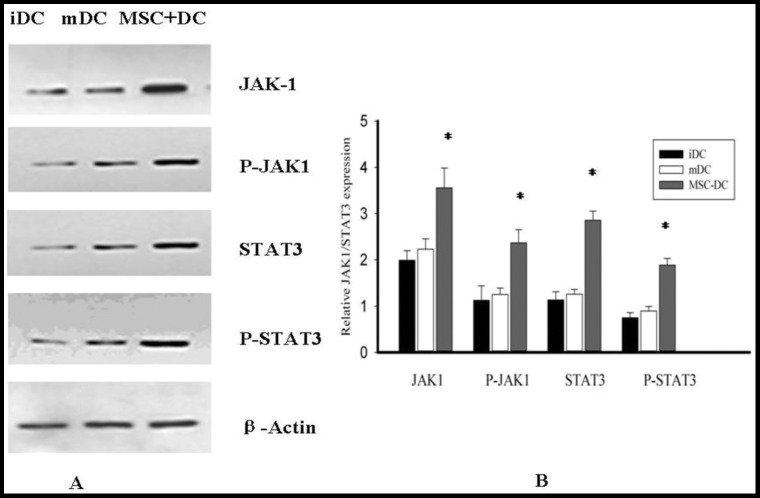
Protein expression of JAK1, P-JAK1, STAT3 and P-STAT3 in monocultures of iDCs, mDCs and in co-cultures of MSC-DC (MSC:DC ratio of 1∶10).(A) Western Blot; (B) Quantification by image analysis of the protein expression. * P<0.05 (MSC-DC group versus mDC group).